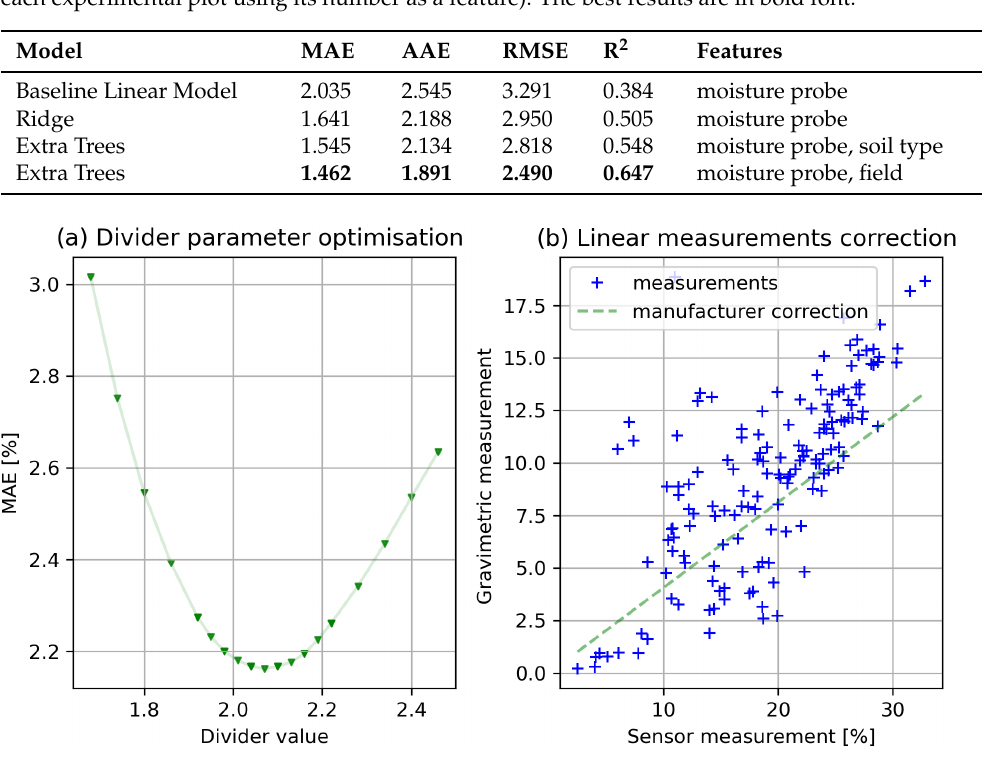
Table 2. Results for models with additional training features (to distinguish different soil profiles or each experimental plot using its number as a feature). The best results are in bold font.